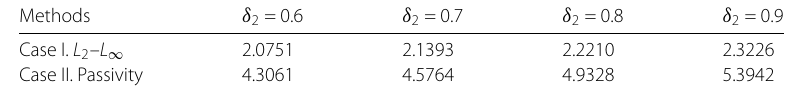
Table 4 Minimum γ for Case I and Case II in Example 4.4 with δ 1 = 0.5, and various δ 2 Methods δ 2 = 0.6 δ 2 = 0.7 δ 2 = 0.8 δ 2 =